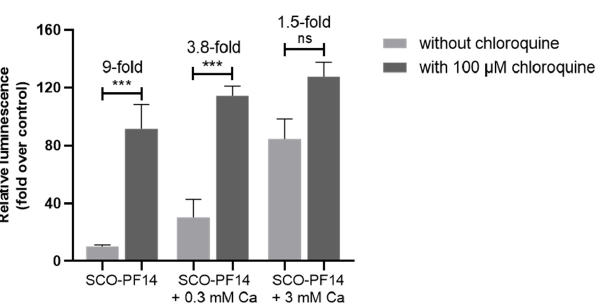
Figure 7. SCO-PF14 nanoparticles rescue luciferase expression in HeLa pLuc 705 cells and reduce effect of endo-somolytic agent chloroquine. HeLa pLuc 705 cells were incubated with nanoparti- cles of 100 nM SCO, 500 nM PF14 and 0.3 or 3 mM Ca 2+ in growth medium with or without 100 μ M chloroquine. After 4 h, the solutions were exchanged to fresh growth medium and